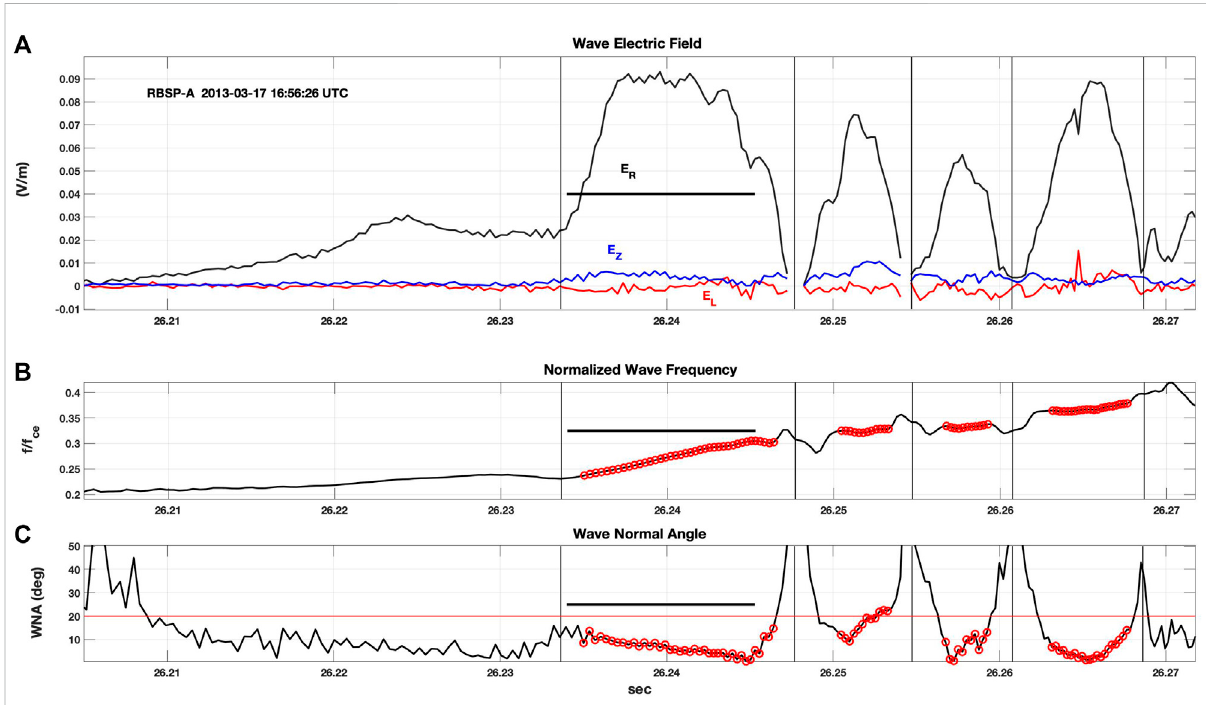
FIGURE 4 Five well-de fi ned subpackets are seen during a strong chorus element at16:56:26 UT. A black horizontal line in each panel highlights the11 ms interval further analyzed and described inFigures 5, 6, 9 – 11. (A) Magnetic fi eld aligned (E Z )and right(E R )and left(E L )circularly polarizedcomponents of the wave electric fi eld reveal an initial slowly growing subpacket followed by a second strong subpacket with E R reaching 80 mV/m. (B) Normalized wave frequency (f/f ce local) rises steeply during the strong second subpacket. Time intervals with E R > 40 mV/v are highlighted in red in all panels. (C) Subpacket development is characterized by wave normal angle (WNA) < 20 deg (red line). During the second subpacket WNA decreases steadily from 16 deg to 2